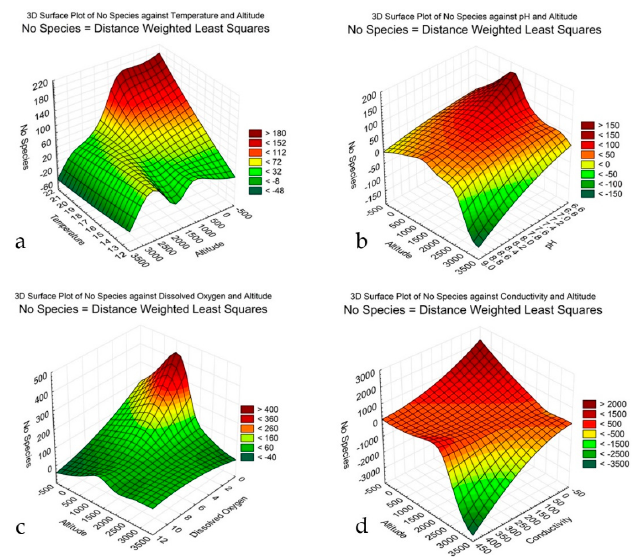
Figure 10. Distribution of diatom species richness over major environmental variables in the lakes of Rize province, the Artabel Lakes in Gümü ş hane province, and other lakes in northern Turkey based on Table 3. Distance Weighted Least Squares dependence of species richness on environmental parameters: ( a ), water temperature and altitude; ( b ), pH and altitude; ( c ), Dissolved oxygen and altitude; ( d ), water conductivity and altitude.